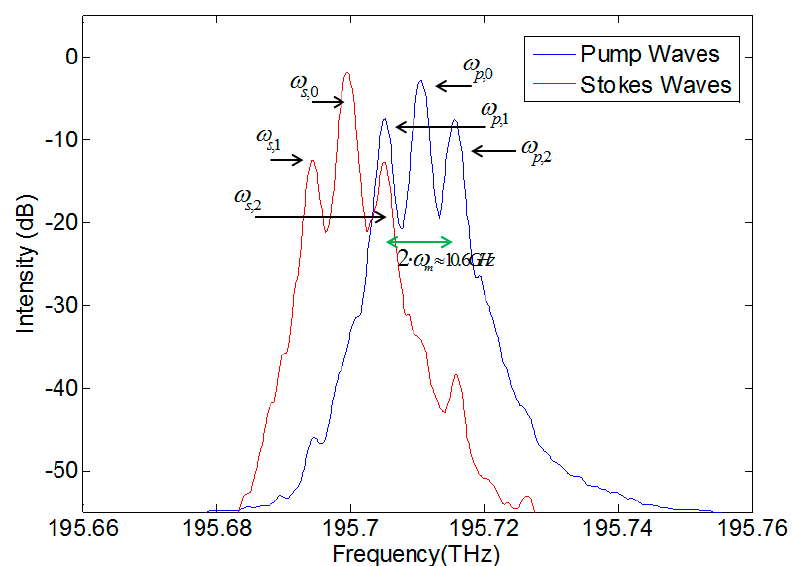
Figure 2. The spectrum of the input (pump waves) and the back-reflected (Stokes waves) signals, measured by optical spectrum analyzer (OSA).